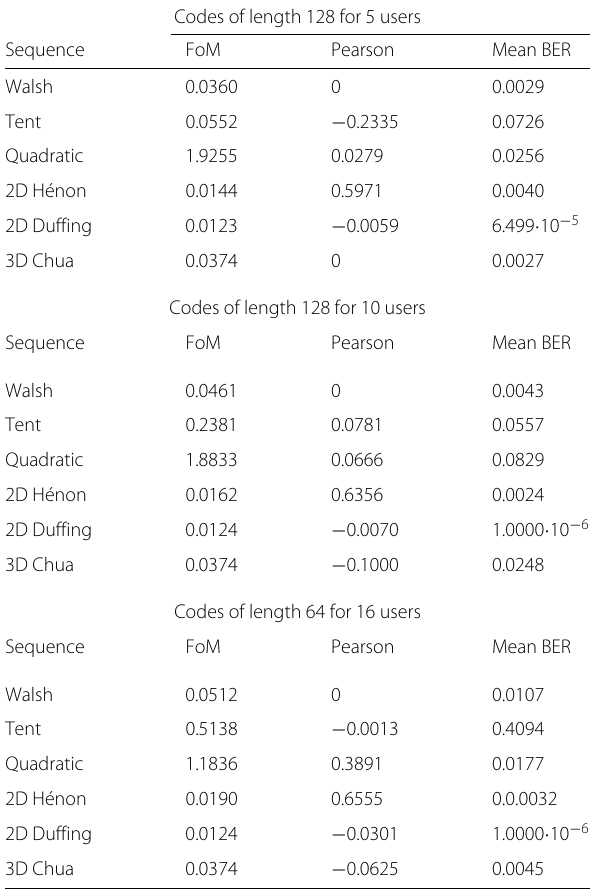
Table 3 Correlation properties for codes of length 128 Codes of length 128 for 5